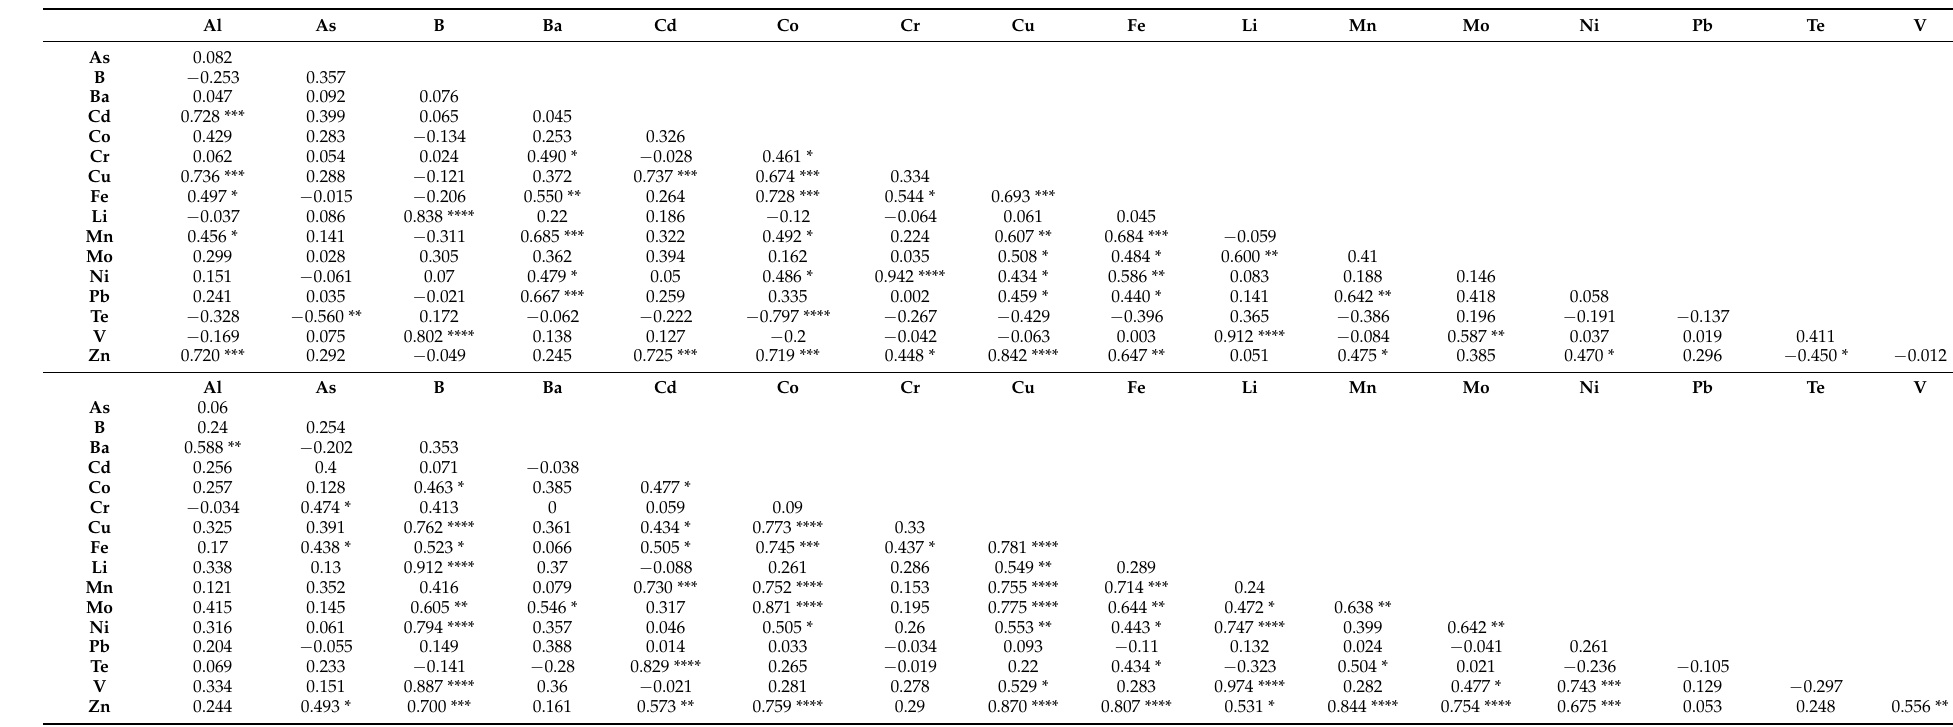
Table 4. Pearson’s correlation matrix for trace elements in umbrella tissue of R. pulmo . Number of samples = 21. p < 0.0001 ‘****’; p < 0.001 ‘***’, p < 0.01 ‘**’, p < 0.05